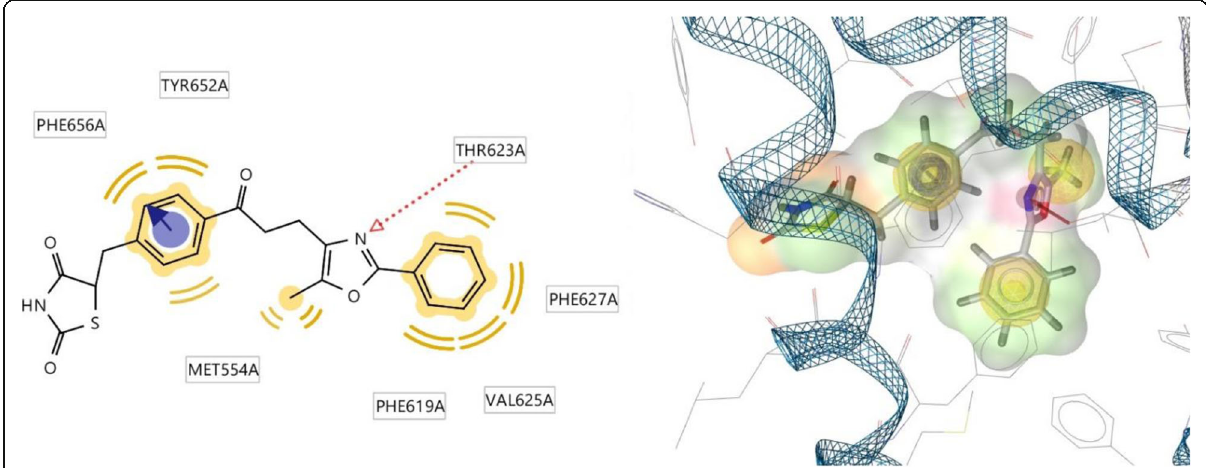
Fig. 3 The binding mode of Darglitazone within the active site of 5VA1. The hydrogen bond is presented in red-dotted line and aromatic interaction in